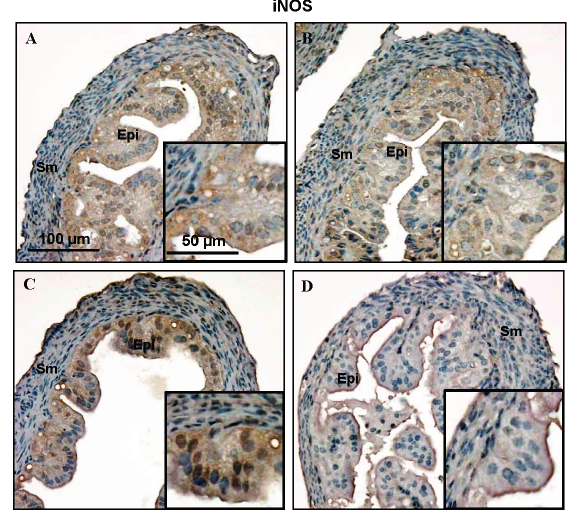
Figure 3. Immunochemical detection of the cellular distribution of iNOS expression in the mouse Fallopian tube at different stages of the estrous cycle ( A – D ) with diaminobenzidine (DAB). All slides were counterstained with hematoxylin. Enlarged views of one part are shown in the lower right corner in each picture. Epi: epithelial cells; Sm: smooth muscle cells. ( A ) diestrus; ( B ) proestrus; ( C ) estrus; ( D ) metestrus. Scale bar = 100 µm in the main picture and 50 µm in the enlarged